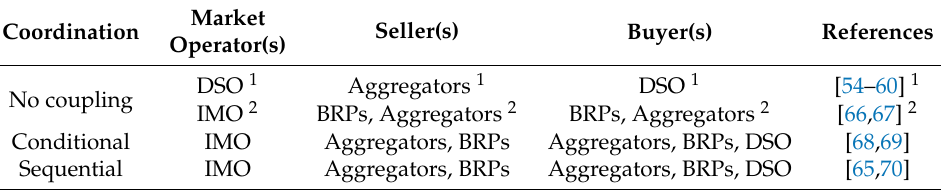
Table 2. Different coordination options for grid and market flexibility